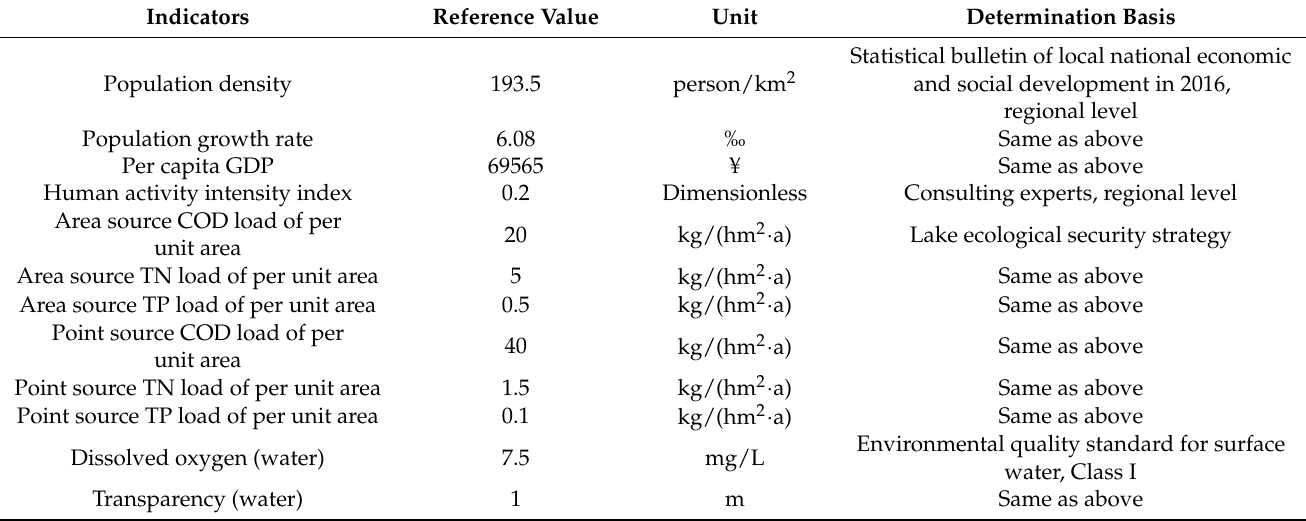
Table A4. Reference standard and basis for determination of each indicator.